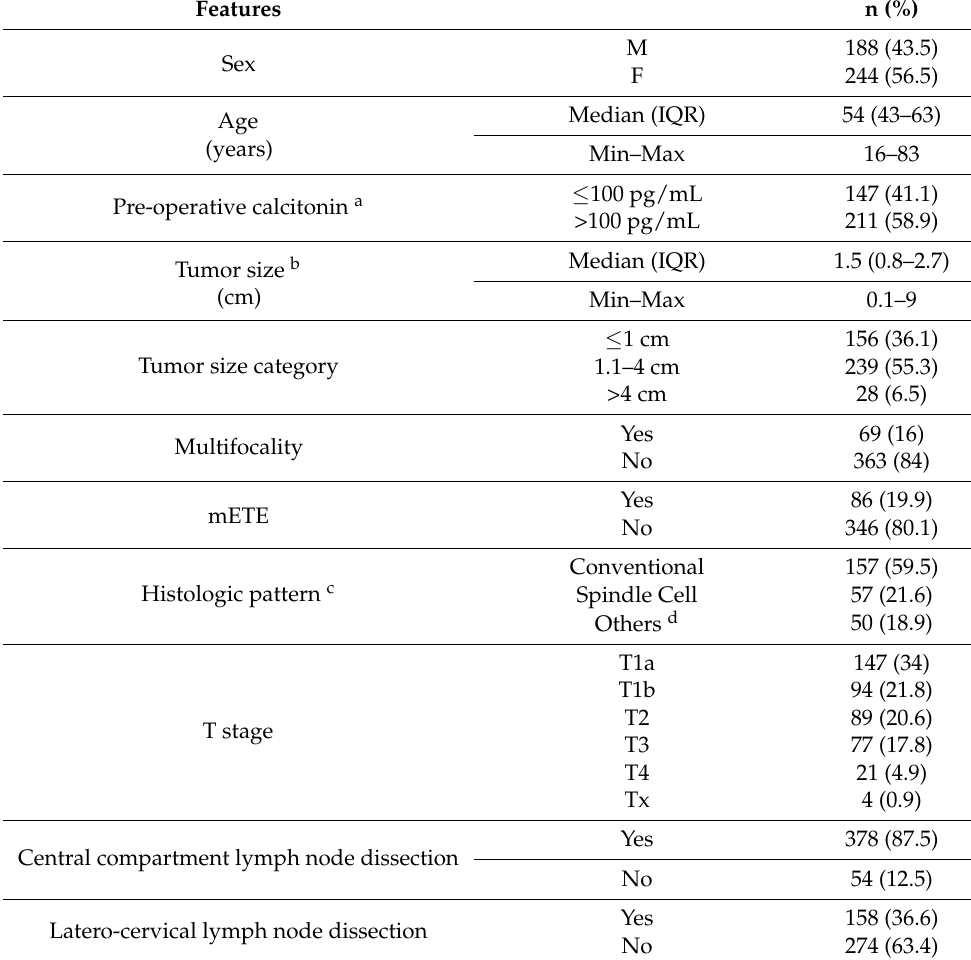
Table 1. Epidemiologic, clinical and pathologic features of the 432 sporadic medullary thyroid carcinoma